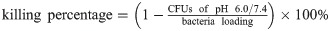
Extracellular acid enhance neutrophil endocytosis but suppress the bacteria killing ability.(A,B,C,D) Neutrophils endocytose FITC-Zymosan. 2×106 neutrophils were mixed with 1×107 opsonized FITC-Zymosan and co-incubated at 37°C for 30 min. Pictures were captured by a fluorescence microscope(600×). (A) Percentage of neutrophils happened to phagocytose. More than 100 cells were counted from random fields of each group. (B) Phagocytosis index was expressed as the number of the internalized particles per 100 neutrophils. (C) Binding index was expressed as the number of the binding particles per 100 neutrophils. (D) Fluorescence images of neutrophil phagocytosis. (E,F,G)Killing assay using neutrophils incubated with E.Coli.2×106 neutrophils were mixed with 1×107 opsonized E.Coli and co-incubated at 37°C for 30min. (E) Cells containing E.Coli were lysed, diluted and spread on the LB agar. CFUs of this group stand for the bacteria loading. Another two groups of neutrophils containing E.Coli were further incubated in the medium of pH 6.0 and pH 7.4 separately. After incubated for another 30 min, cells were lysed, diluted and spread on the LB agar. (F) The number of CFUs of each group were listed in the table. (G)killing percentage=(1-CFUs of pH 6.0/7.4bacteria loading)×100%. Data are from three independent experiments(A,B,C) or are representative of three experiments(D,E,F,G,H,I). (***,p<0.001, **, p<0.01, *,p<0.05).